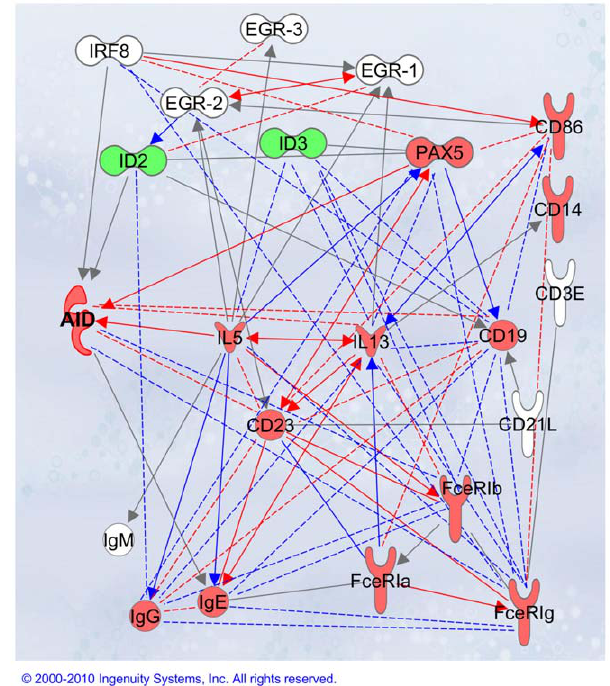
Figure 5. AID-associated gene network. Multigene signature- based network displaying AID as a key gene was created using the Ingenuity Pathway Analysis Software (IPA; http://www.ingenuity.com). The color code of transcripts indicates up- (red) and down-regulation (green) of genes in the NP disease group in comparison to rhinosinusitis without polyps. Solid lines in grey display the IPA-identified direct associations between transcripts; solid lines in red or in blue reflect the IPA-identified associations overlapping with the 25-gene-identified molecular interactions. The multigene approach including the analysis of co-regularities can be extended to find not-yet-identified functional links between the genes under investigation; statistically significant, study-based biological associations (SYSTAT program; Table S6) are displayed by dashed lines; color code: red for correlation coefficient $ 0.6, p , 0.0001; blue for correlation coefficient , 0.6, p ,